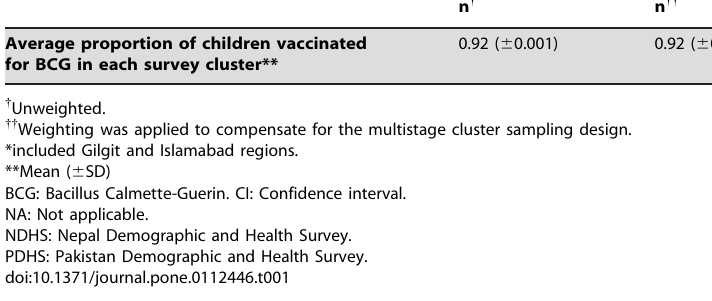
Nepal Pooled NDHS (2001, 2006 and 2011)